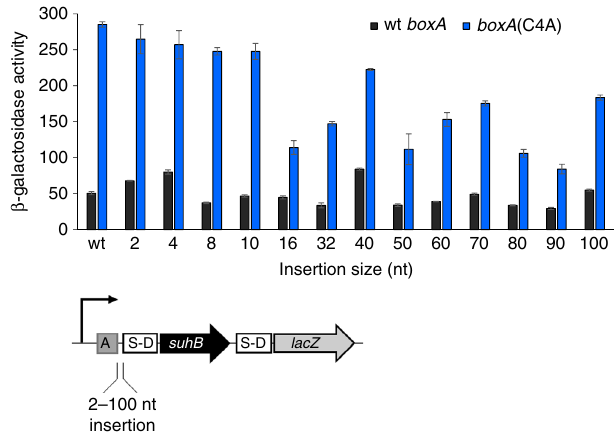
Fig. 5 The effect on suhB-lacZ transcription levels of altering the distance between boxA and the S-D sequence. β – galactosidase activity of wild-type ( ‘ wt boxA ’ ; dark grey bars) and boxA mutant ( ‘ C4A ’ ; blue bars) transcriptional fusions of suhB to lacZ , with increasing lengths of non-coding DNA inserted between the boxA and S-D sequences. The length of inserted sequence (nt) is indicated on the x -axis. Constructs include 200 bp of upstream sequence and a full-length suhB fused to lacZ in the pAMD-BA- lacZ plasmid. Note that the sequence of inserted non-coding DNA differs for constructs with insertion sizes of ≤ 32 bp and ≥ 40 bp (see Methods and Supplementary Fig. 6 for